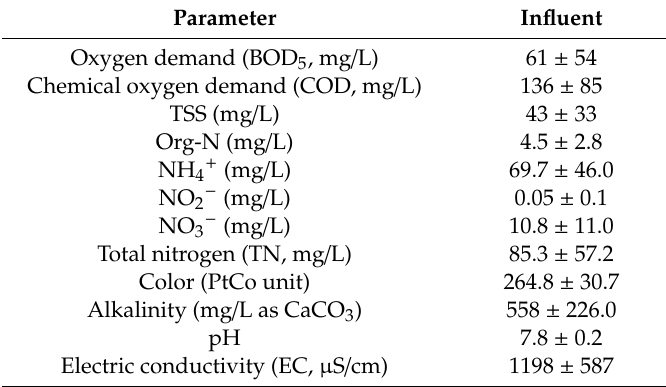
Table 1. Wastewater characteristics along the period of study (average ± standard deviation, n =